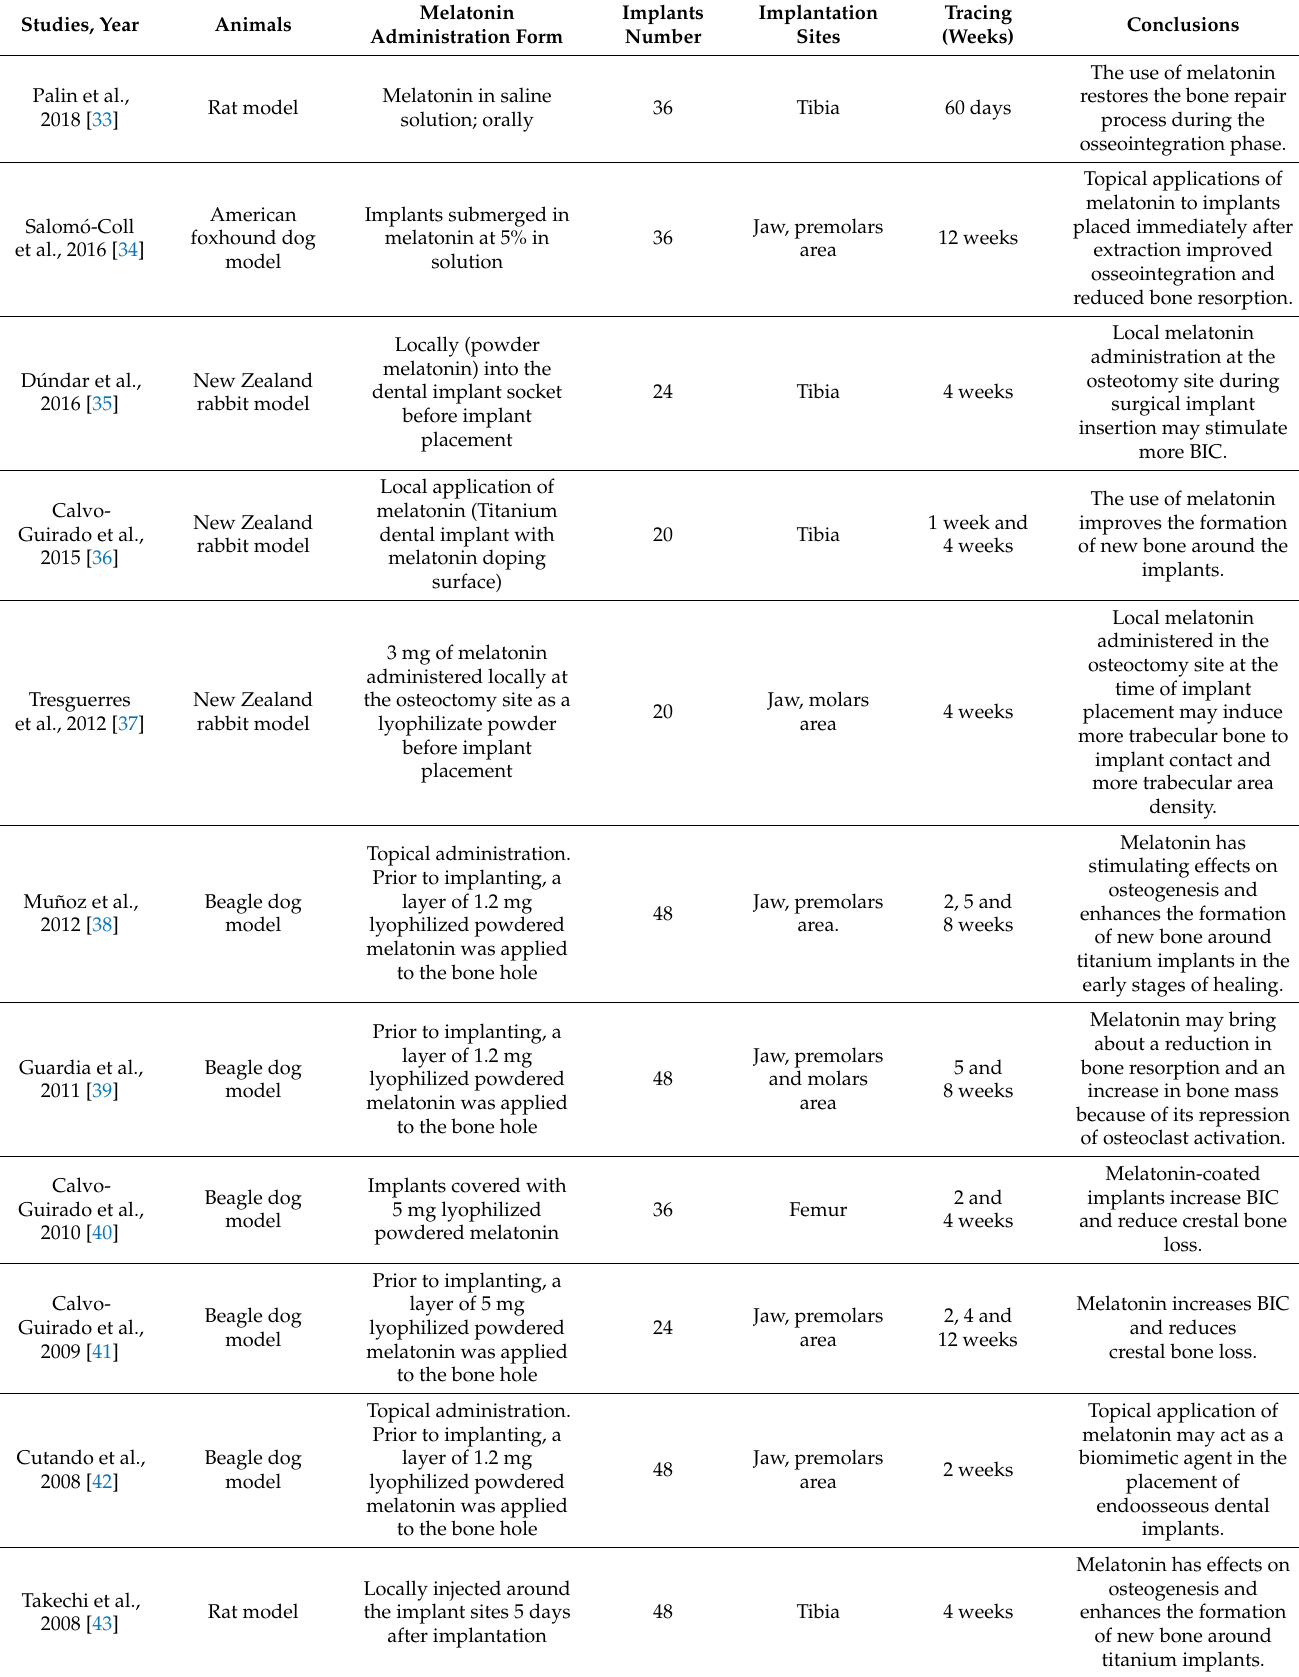
Table 3. Characteristics of Animal